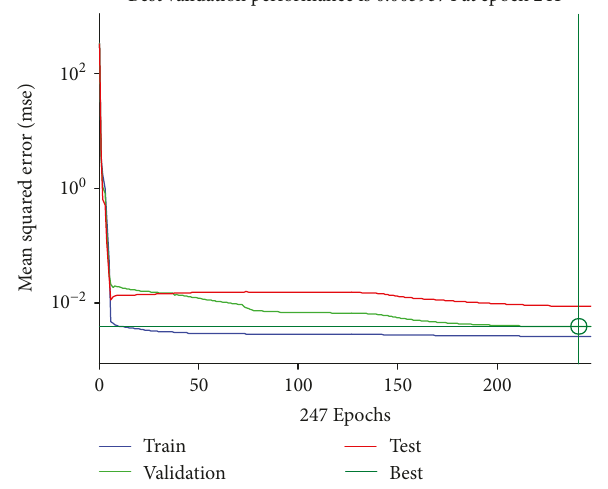
Figure 10: The training of